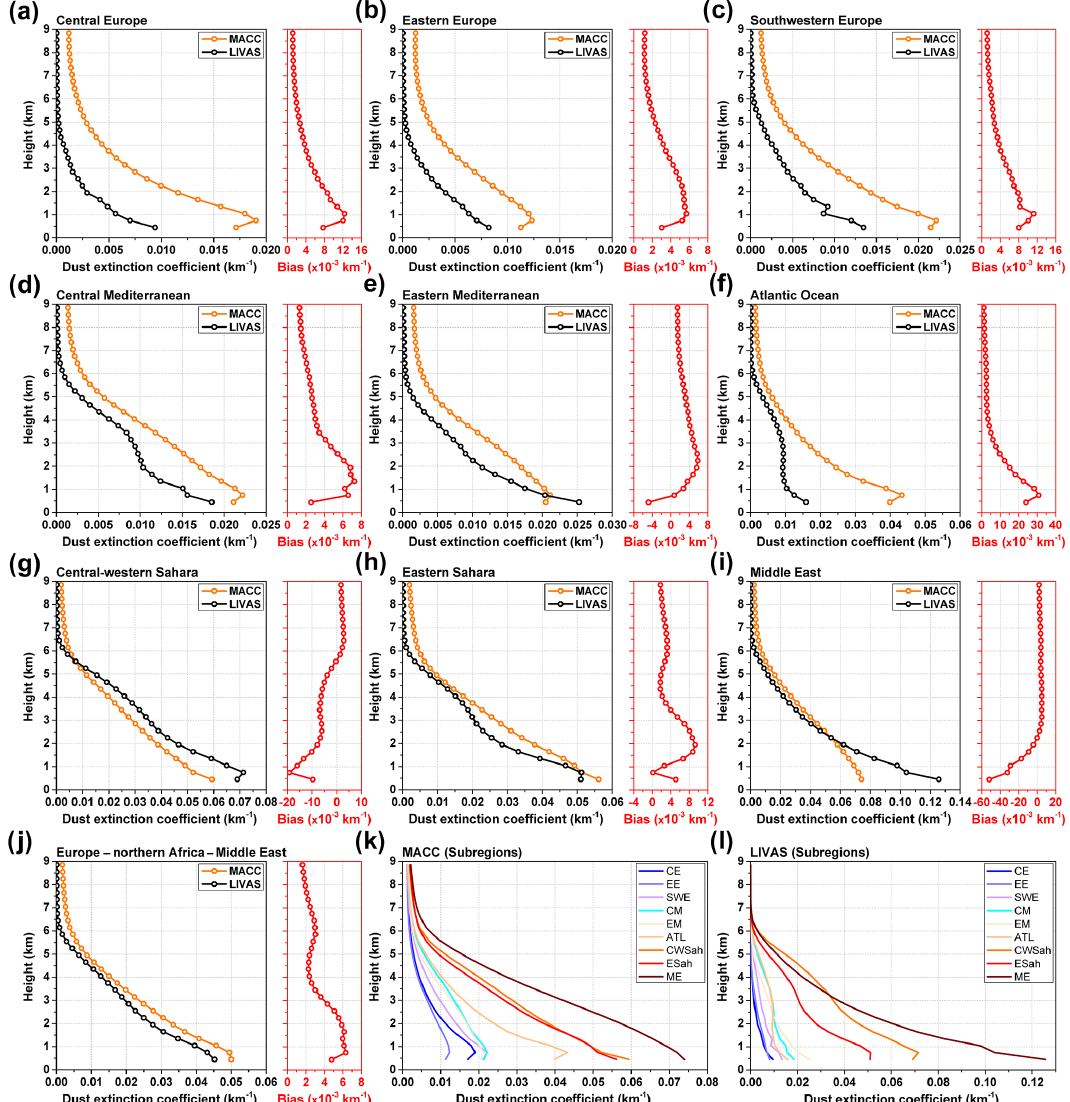
Figure 6. The 300m resolution profiles of the MACC dust extinction coefficient at 550nm (in km − 1 ) (orange color), the LIVAS dust extinction coefficient at 532nm (in km − 1 ) (black color) and their mean bias (red color) over the nine subregions of interest (a–i) and over the whole Europe–northern Africa–Middle East domain (j) . Different scales are used for each subregion so that the differences between the two datasets per subregion are depicted more efficiently. The profiles for all the subregions of interest together for MACC (k) and LIVAS (l) are also presented here to get an insight into the dust profile differences over different